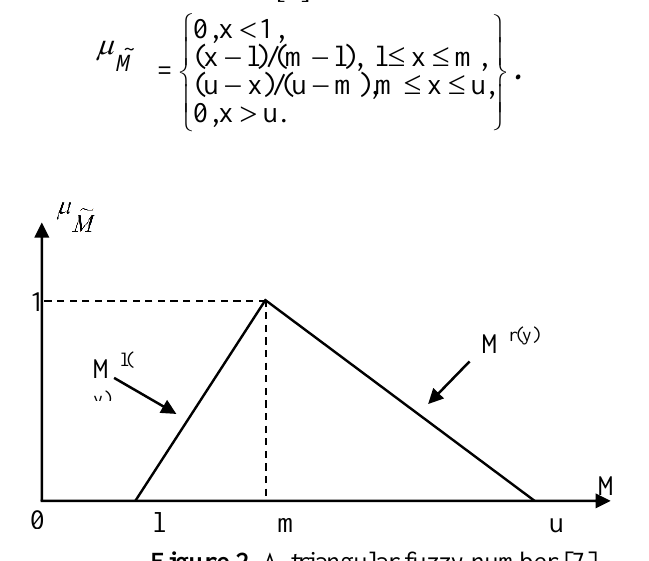
Figure 2 . A triangular fuzzy number